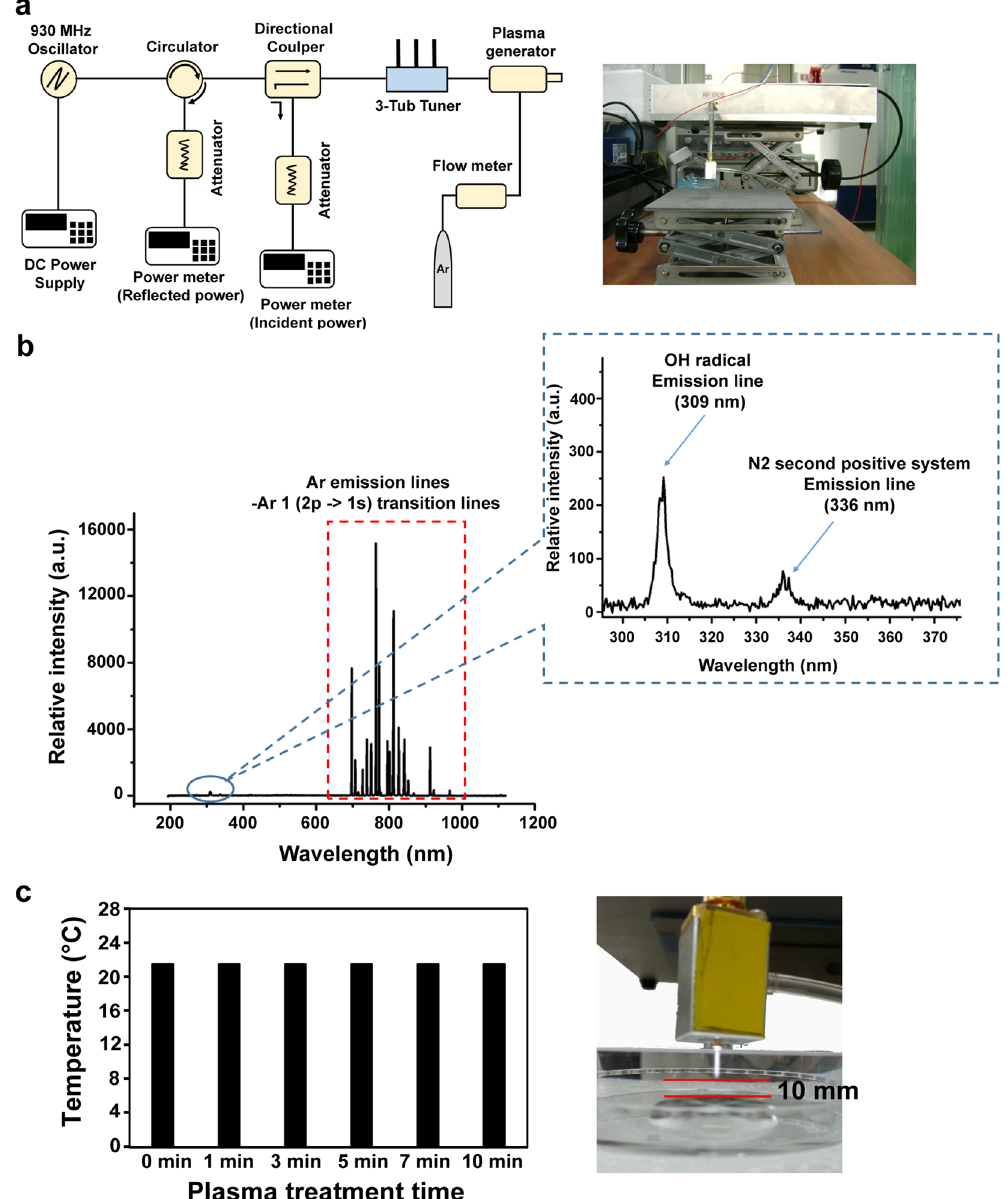
Figure 1. ( a ) Schematic view of microwave-pulsed non-thermal atmospheric pressure plasma (NTAPP) impedance system. ( b ) Optical emission spectra of microwave-pulsed NTAPP with Argon (Ar) gas; Ar emission lines at 650 to 950 nm; OH emission band at 306 to 309 nm; and nitrogen second positive system at 330 to 400 nm. ( c ) Temperature of deionized water treated with microwave-pulsed NTAPP for different lengths of time. The distance between the upper surface of the solution and the bottom of the plasma plume was 10